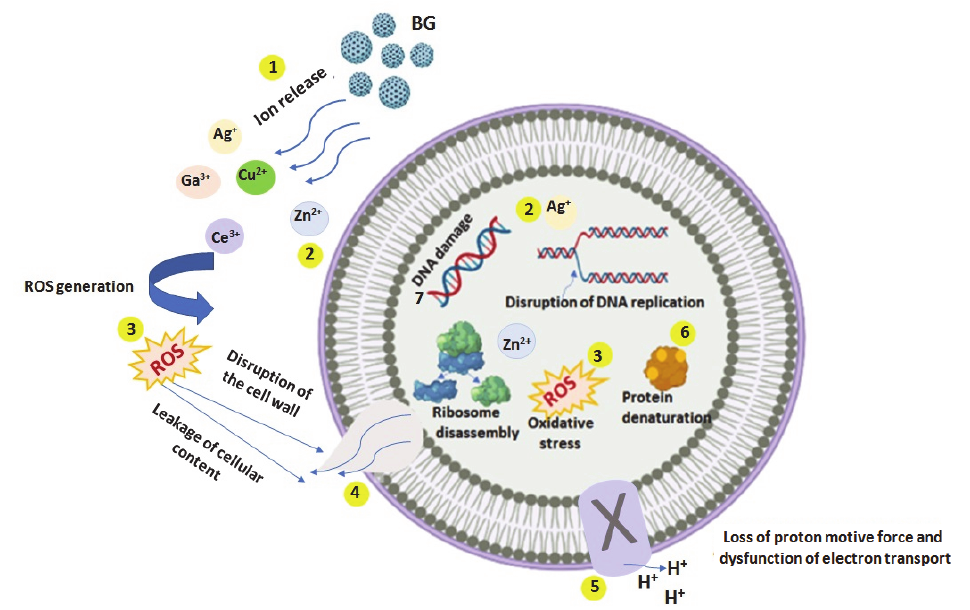
Figure 2. Graphic representation of the antibacterial mechanism of metal ions (created with Bio- Render.com (accessed on 1 September 2022). ( 1 ) metal ion release from BG; ( 2 ) direct interaction of the metal ions with the cell wall ( 3 ) generation of ROS (extracellular and intracellular); ( 4 ) elevated levels of metal ions and ROS generate the disruption of the cell wall and leaking of cellular content; ( 5 ) high level of ROS causes loss of the proton motive force and dysfunction of electron transport; ( 6 ) depending on metal ions uptake, bacterial proteins and DNA are damaged, leading to the death of the